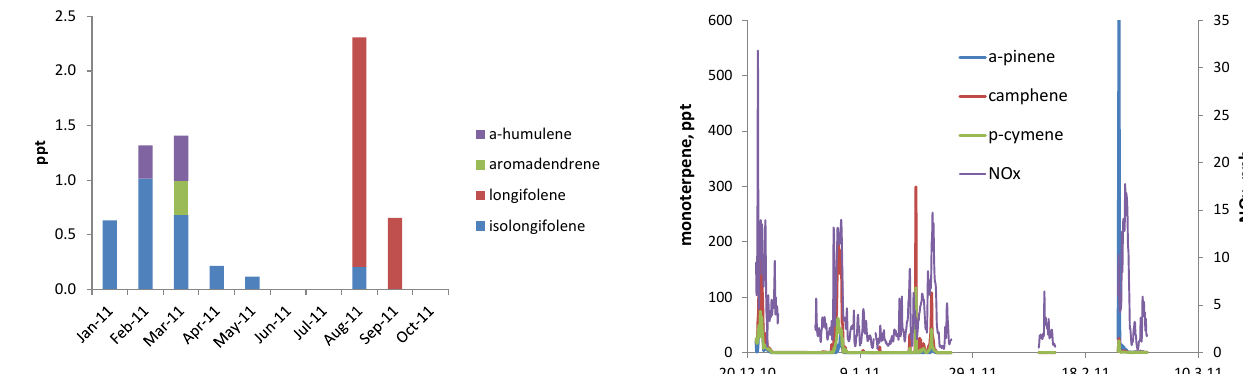
June 2011, 22 June 2011, 20 July 2011, 23 August